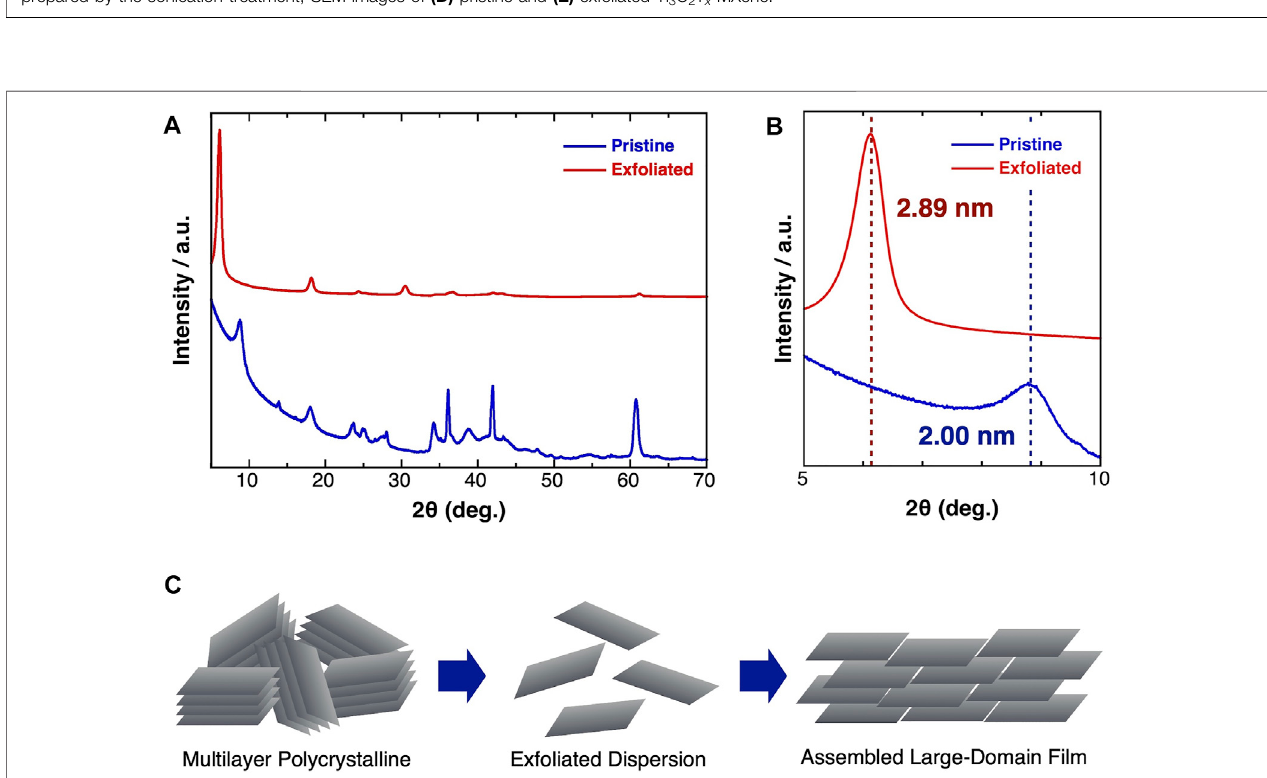
FIGURE 3 | (A) Whole region and (B) magni fi ed XRD pattern of (blue) pristine and (red) exfoliated Ti 3 C 2 T x MXene. (C) Schematic image of the exfoliation process and the fi lm formation process of the exfoliated MXene.